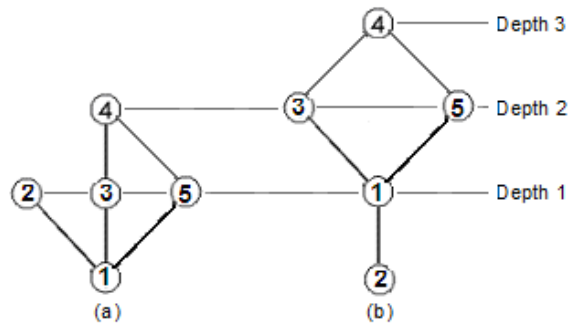
Figure 2. Justified graphs. (a) Axial line 1. (b) Axial line